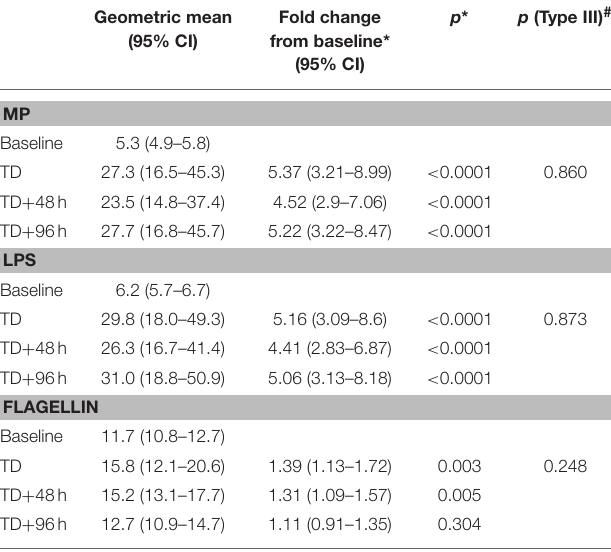
TABLE 2 | Analysis of ALS responses to three antigens (MP, LPS, and flagellin) in participants challenged with ST (baseline) and diagnosed with typhoid infection. Geometric mean (95%